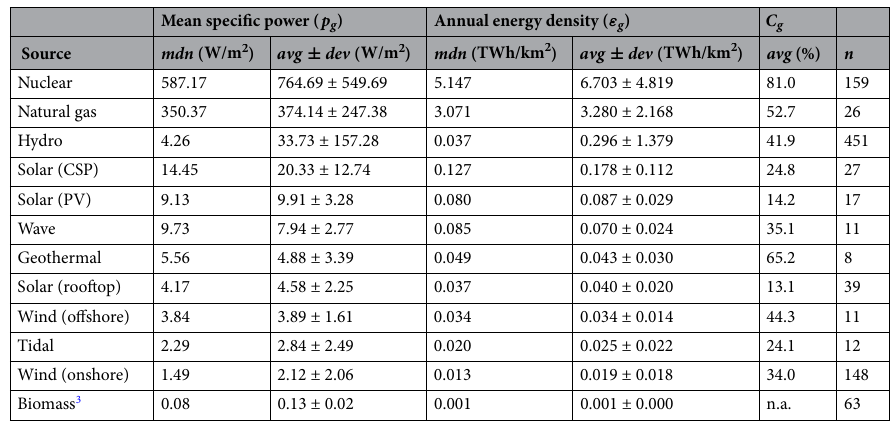
Table 16. Aggregated result of the mean and annual power and energy densities of the 10 different energy resources examined in this paper (cumulative rooftop solar PV technology per country is separated in this table), referring to the data in Figs. 2, 4, 5, 7, 8, 9, 10, 12, and 13. The mean, median and standard deviation are given, as well as the average capacity factor and the number of samples ( n ) per population study. The biomass numbers are based on the meta-analysis of van Zalk and Behrens 3 .